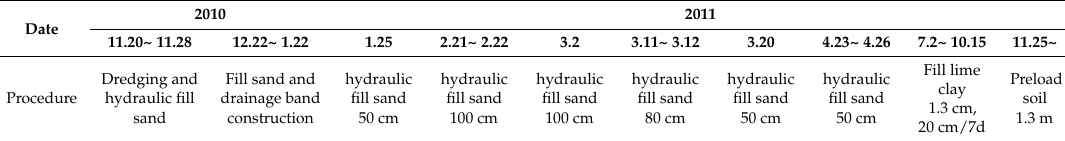
Figure 2. Procedure of construction: ( a ) Mechanical dredging; ( b ) Backfill sand; ( c ) Plastic drainage board; ( d ) Geotextile laid; ( e ) Joining of new and old subgrades; ( f ) Geogrid laid; ( g ) Backfill clay; and ( h ) Pavement construction. Table 1. Construction procedure of the test zone.